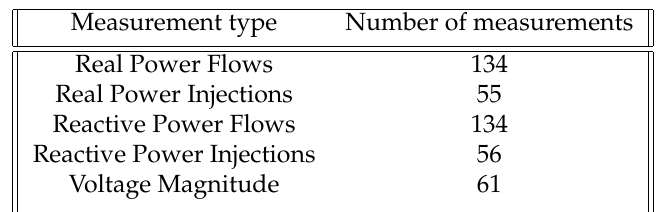
Table 8. IEEE 118 Bus - Measurement distribution